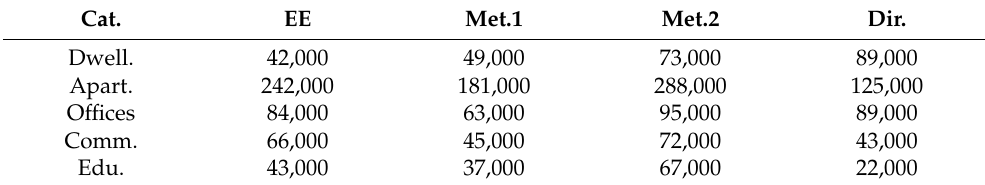
Table 15. CO 2 reduction in 2033 vs. 2020, t/a. Cat. EE Met.1 Met.2 Dir. Dwell. Apart. 242,000 Offices